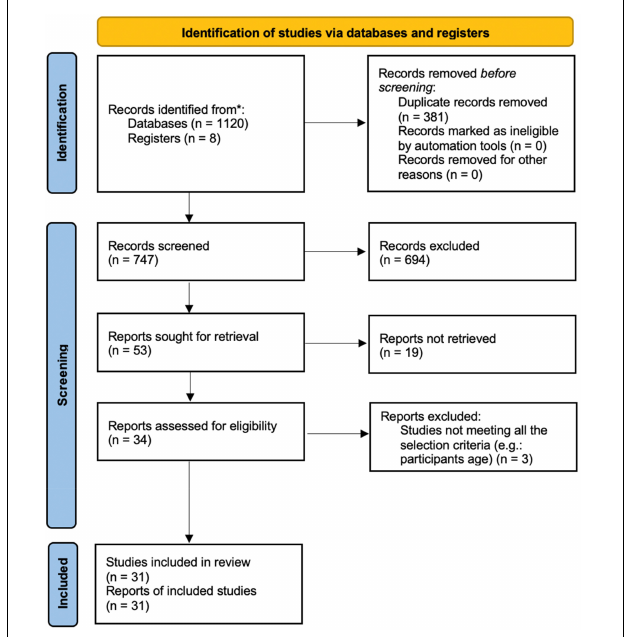
FIGURE 1 | PRISMA flow diagram (Page et al.,